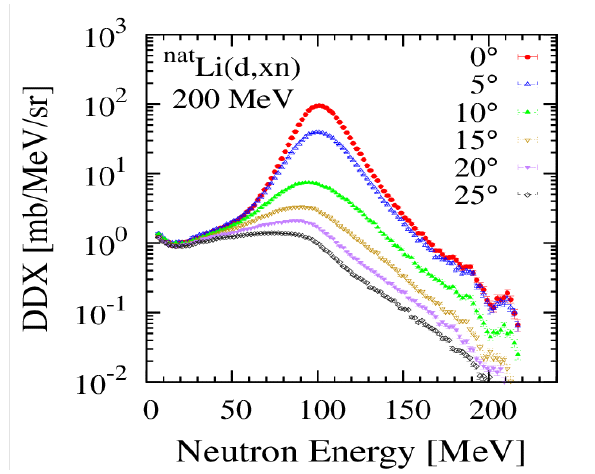
Figure 2. Measured double-di ff erential cross sections (DDXs) of the ( d , xn ) reaction on Li at an incident energy of 200